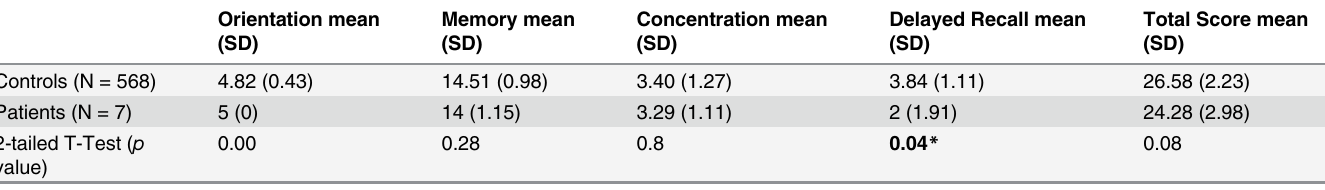
Table 4. mTBI patients' SAC scores compared with normalized SAC